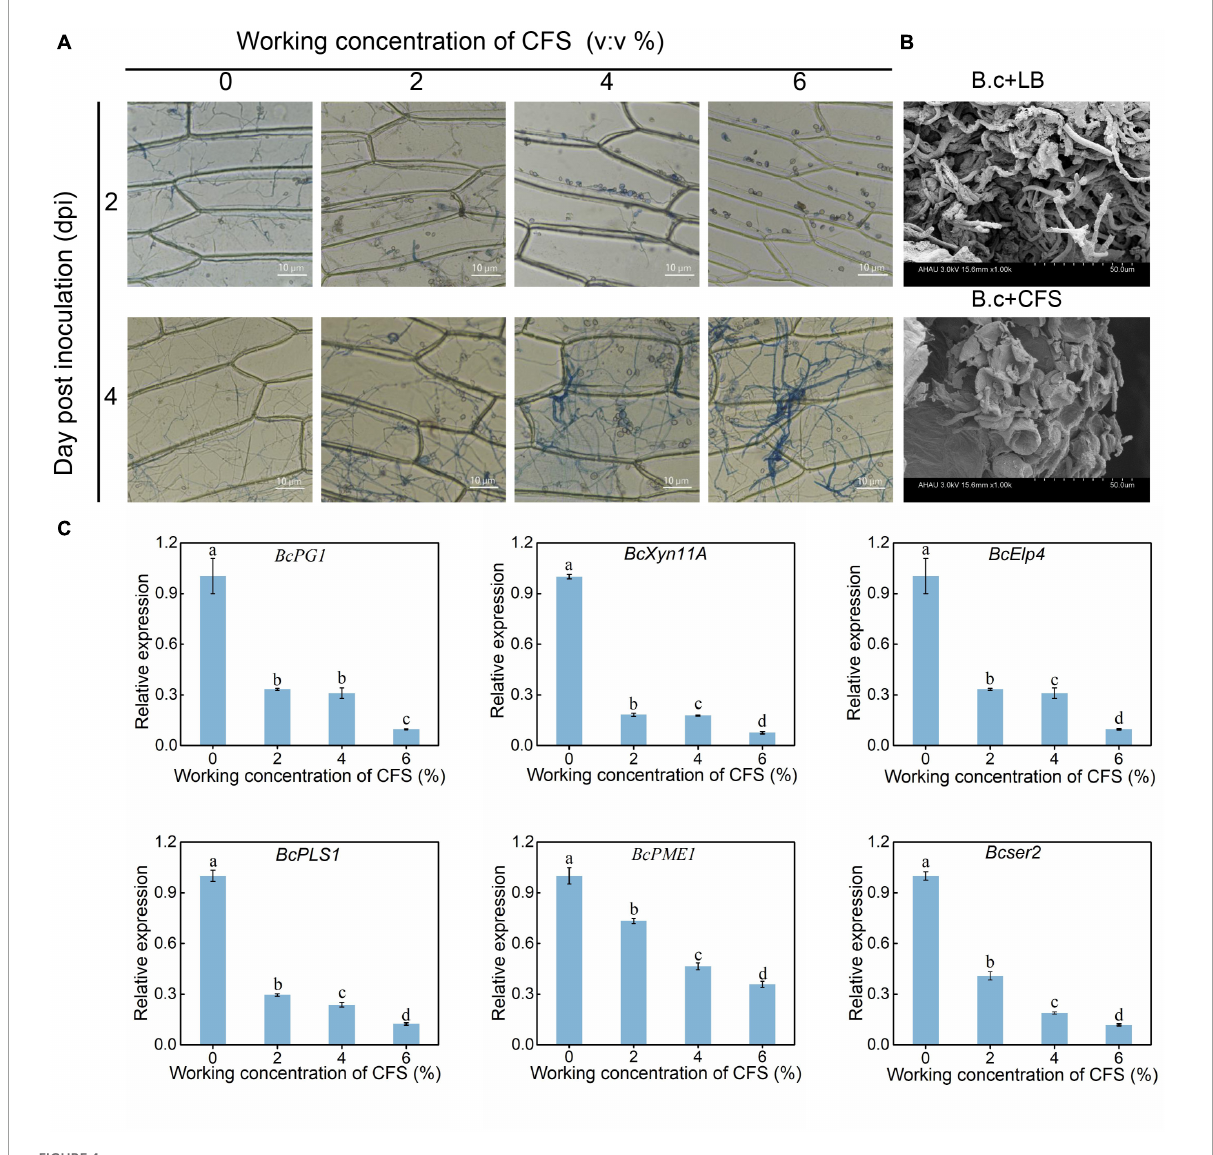
FIGURE4 Effect of cell-free supernatant (CFS) on the ability of Botrytis cinerea to penetrate onion cells and cherry tomato fruit. (A) Onion epidermal peels were cut into 1.5 × 1.5 cm pieces, then were treated with different concentrations of CFS and inoculated with 200 µ L of B. cinerea spore suspension. Images were recorded after inoculation for 2 and 4 days using a microscope. (B) The situ status of B. cinerea spores in tomatoes was detected by scanning electron microscopy (SEM) after 24 h treatment. B.c + LB and B.c + CFS represent that tomatoes inoculation 1 µ L LB liquid medium or cell-free supernatant and subsequently inoculated with 1 µ L spore suspension B. cinerea spore suspension (1 × 10 6 spores/mL), respectively. (C) RT-qPCR analysis of critical genes reportedly involved in regulating the growth or pathogenicity of B. cinerea. The different letters ( p < 0.05) within the same time point denotes a significant difference among several reported